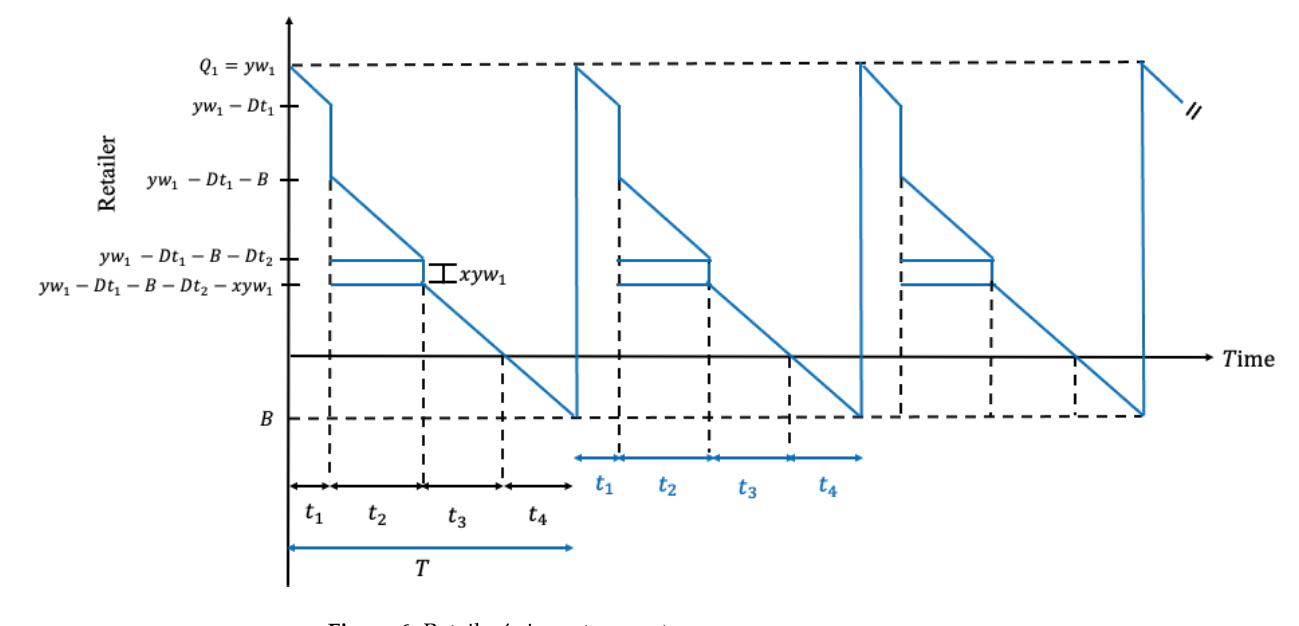
Figure 6. Retailer´s inventory system. Figure 6. Retailer ´ s inventory